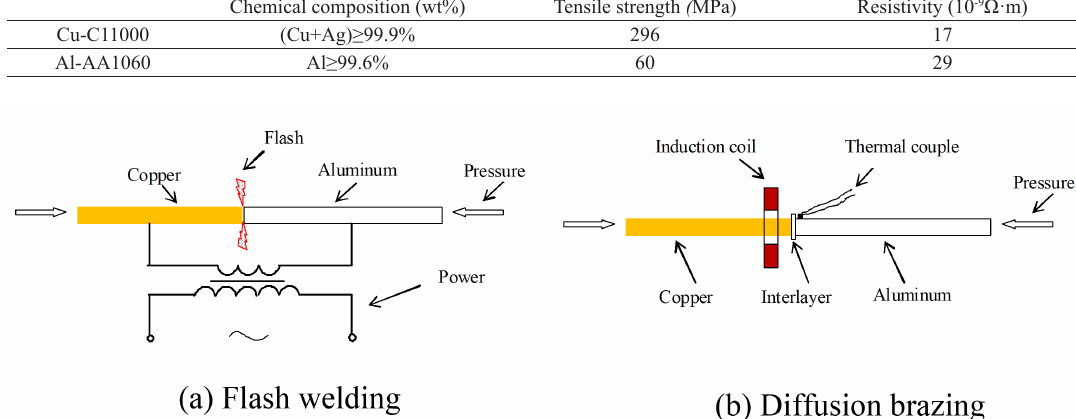
Figure 1. Sketch of Cu/Al butt joints made by different welding methods: (a) Flash welding; (b) Diffusion